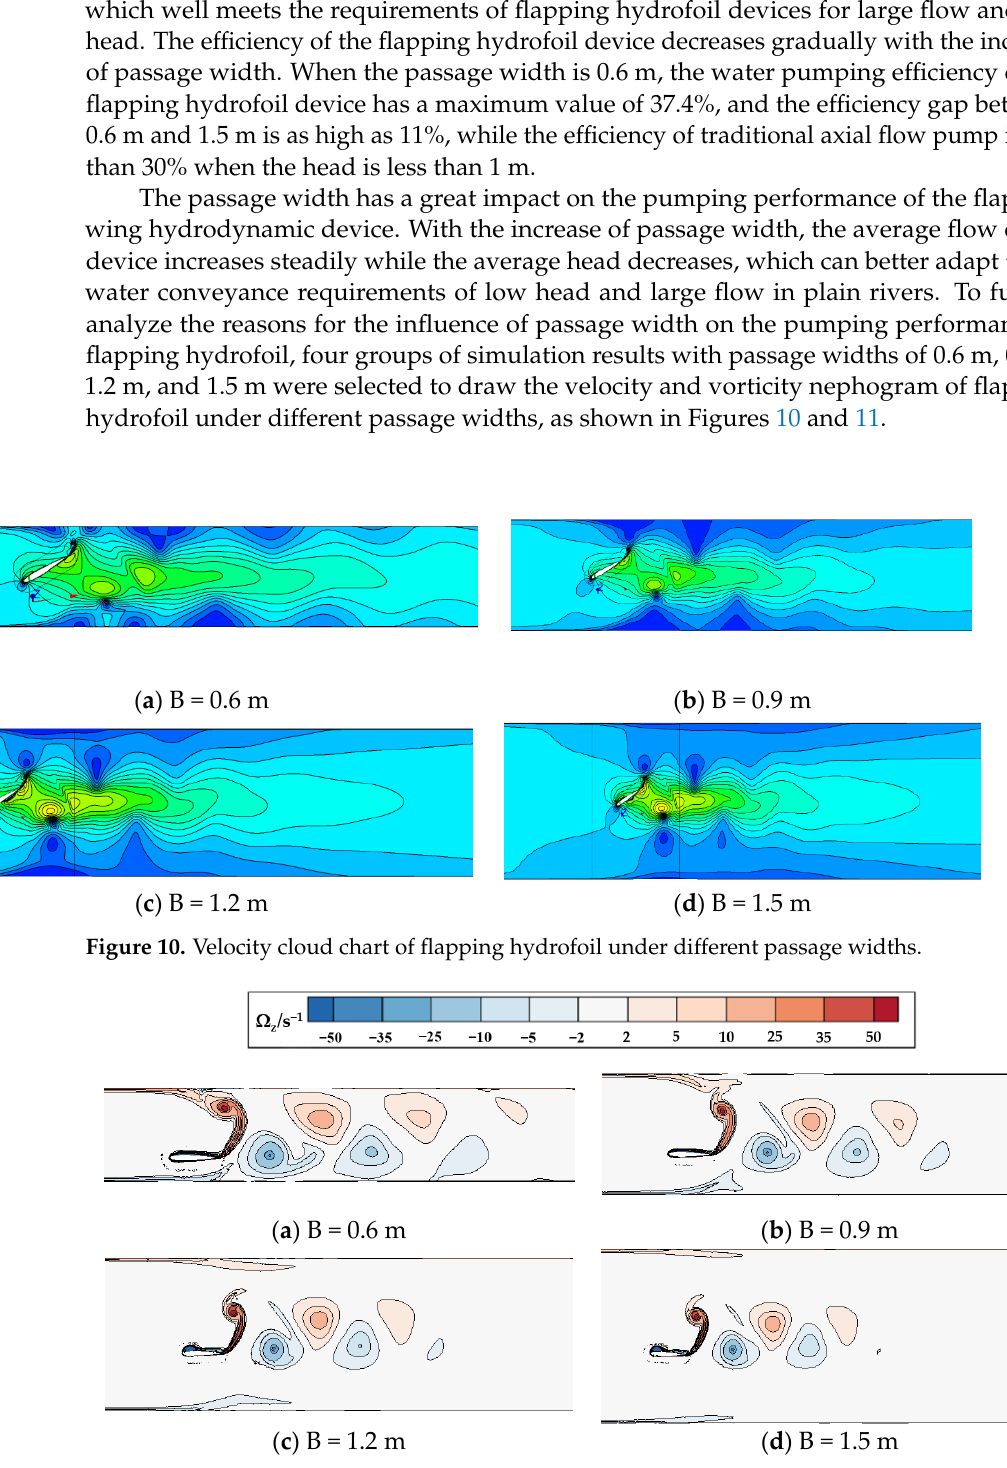
Figure 11. Vorticity cloud maps of flapping hydrofoils under different passage widths.